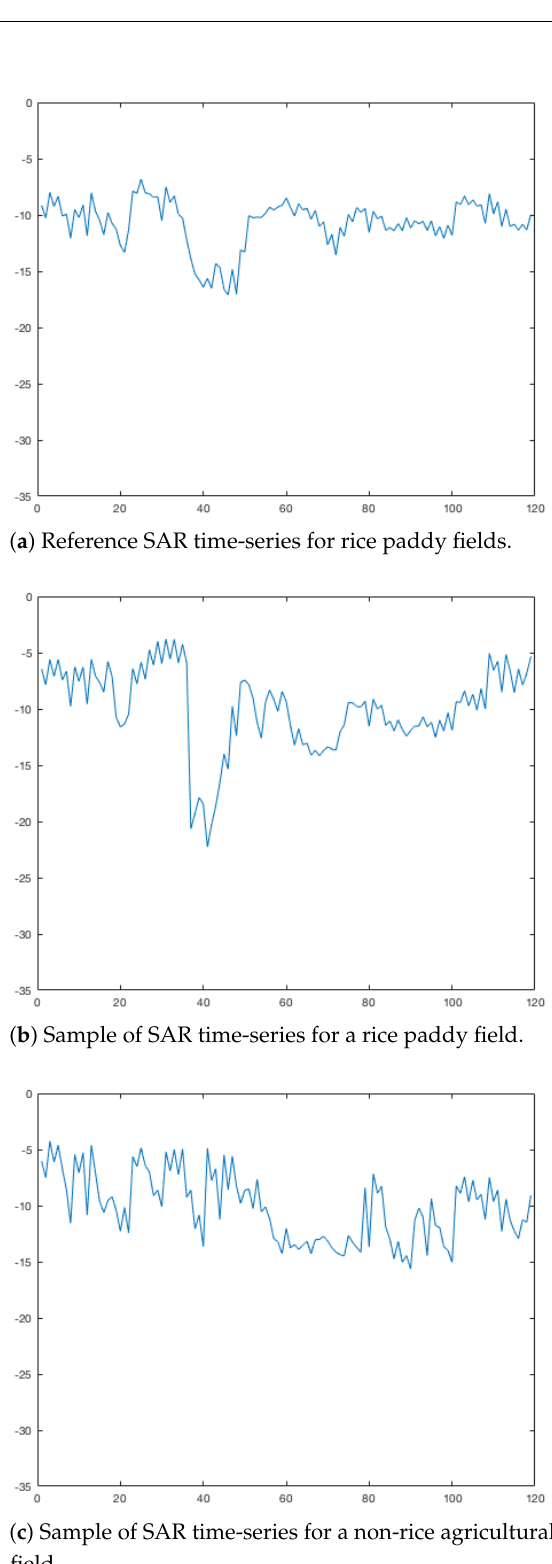
Figure 4. Comparison between ( a ) the reference rice field SAR time-series and other time-series samples: ( b ) sample rice paddy field, and ( c ) non-rice agricultural field. Horizontal axes report the order number of acquisitions, and span one calendar year. The left end is the first satellite pass in the year, and the right end the last